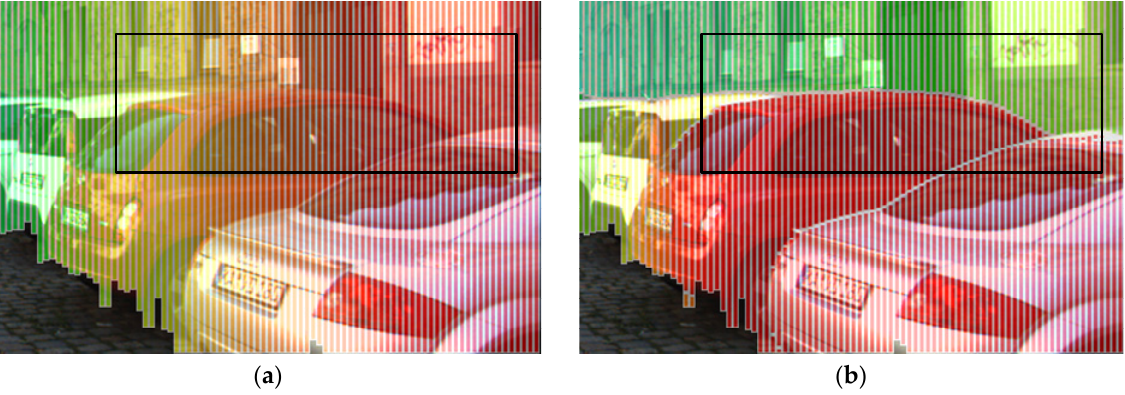
Figure 11. Stixels segmentation result: ( a ) Horizontal segmentation; ( b ) Disparity optimization.